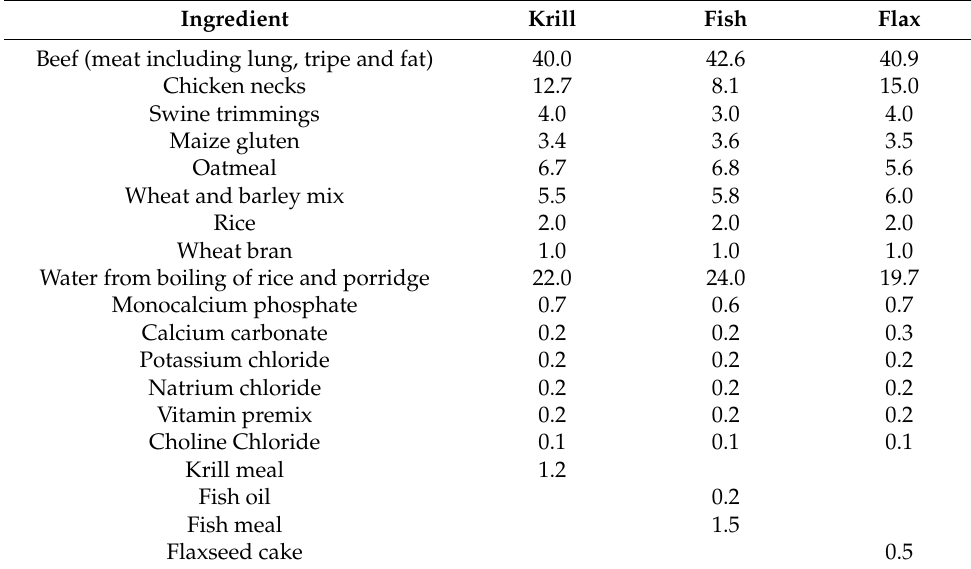
Table 2. Ingredient composition (%) of the three treatment